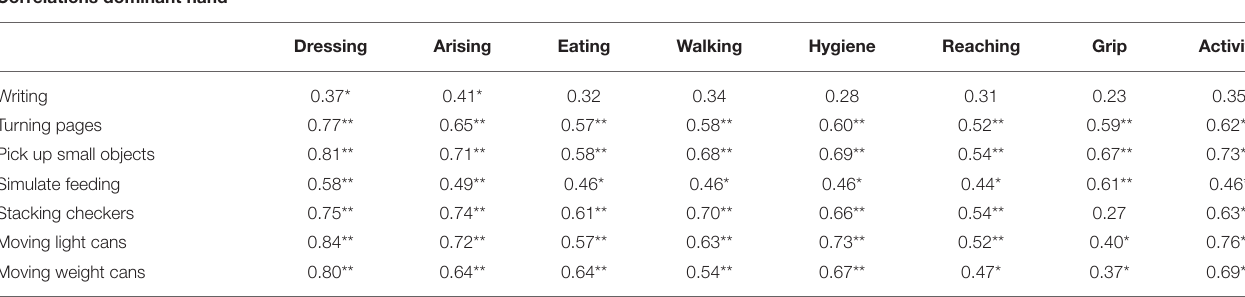
TABLE 4 | Pearsons’ correlation coefficient for dominant hand between JTHFT and HAQ. Correlations dominant